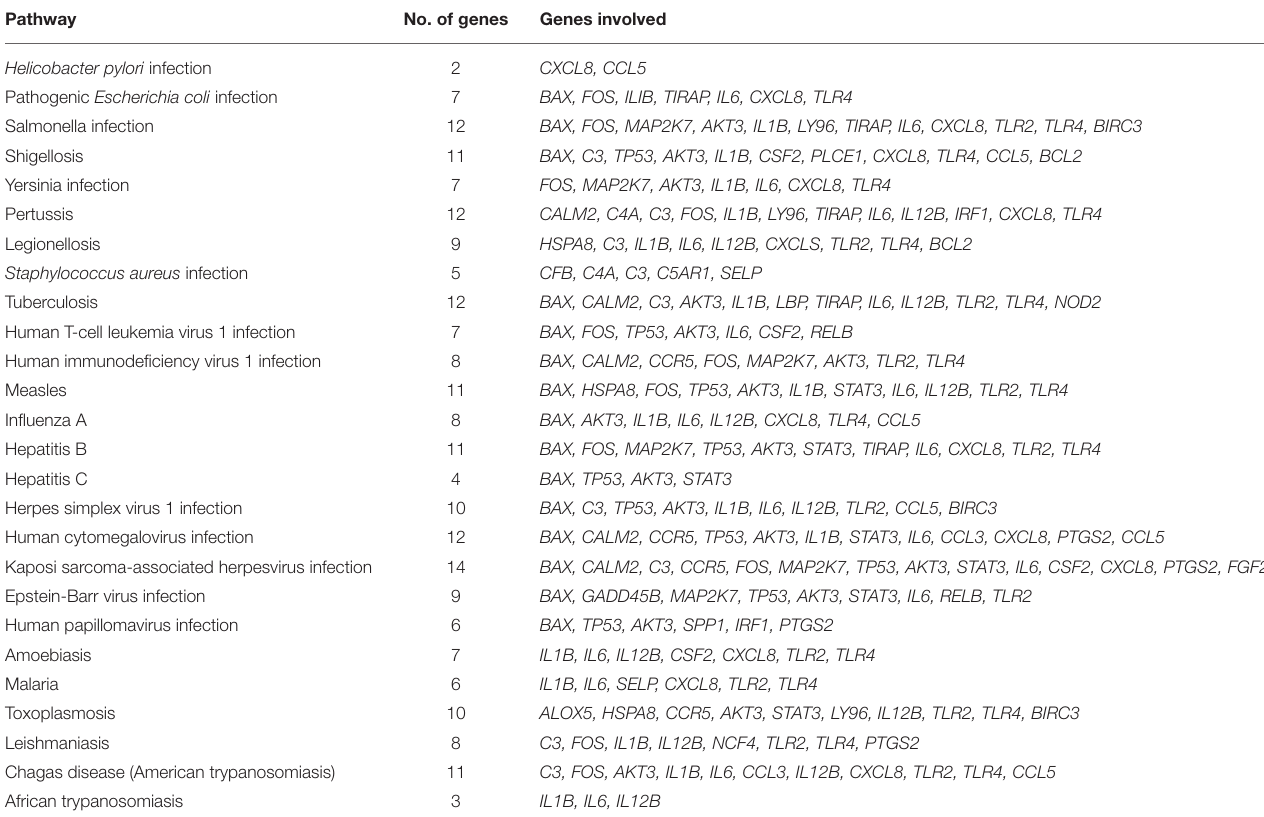
TABLE 2 | Genes of mastitis involved in various infectious pathways. Pathway No. of genes Genes involved